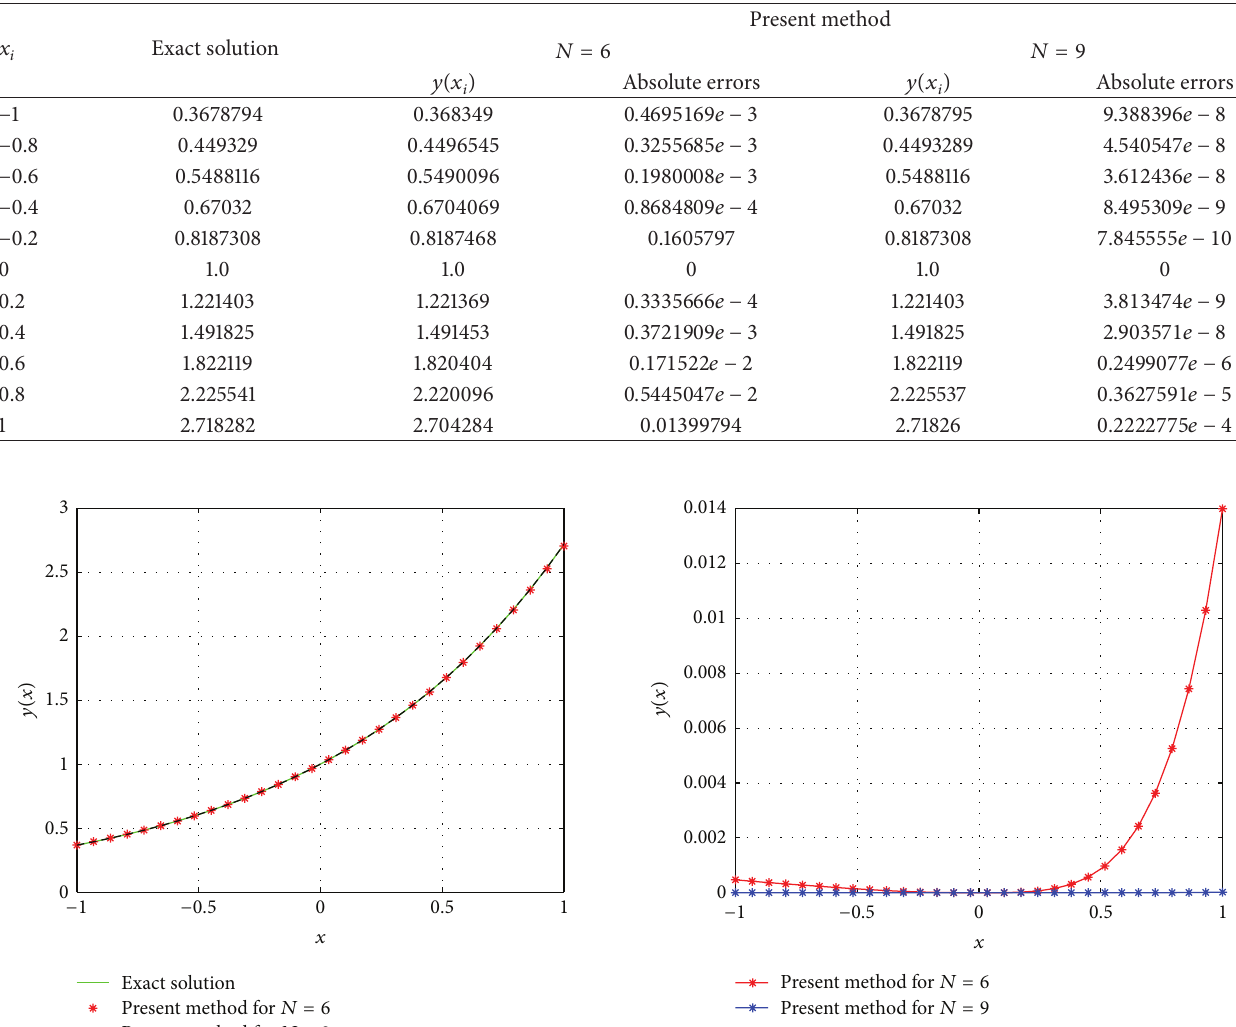
Table 2: Comparison of the absolute errors of Example 5.3.